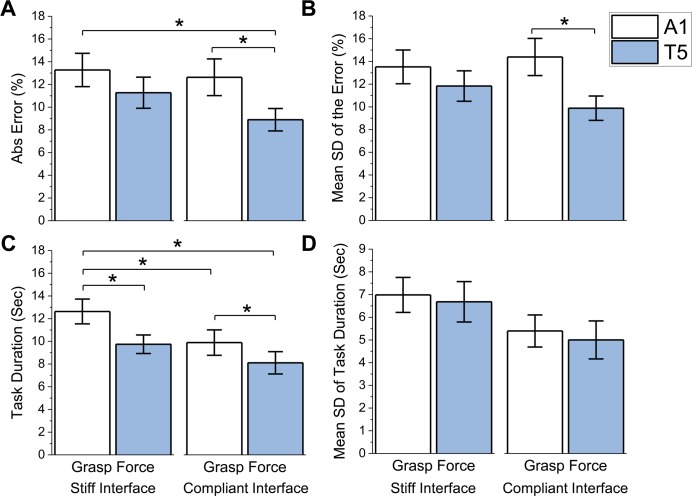
Performance on myoelectric grasp force control tasks with stiff and compliant grasp interfaces.White bars: A1, Shaded bars: T5. A) Mean absolute value of the reach error. B) Variability of the reach error data presented as the mean standard deviation of the reach error. C) Mean task duration D) Variability of the task duration data presented as the mean standard deviation of the task duration. All results (N = 10) include their corresponding SEM. * indicates significant difference (p<0.05).